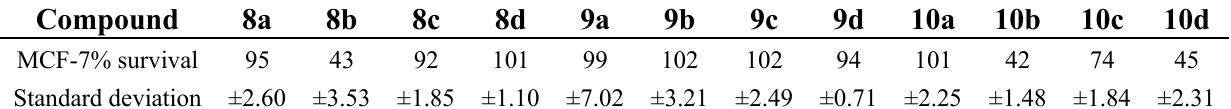
Table 4. Percentage cell survival of MCF-7 following 72 h exposure to 50 µg/mL of 8 – 10 . Compound